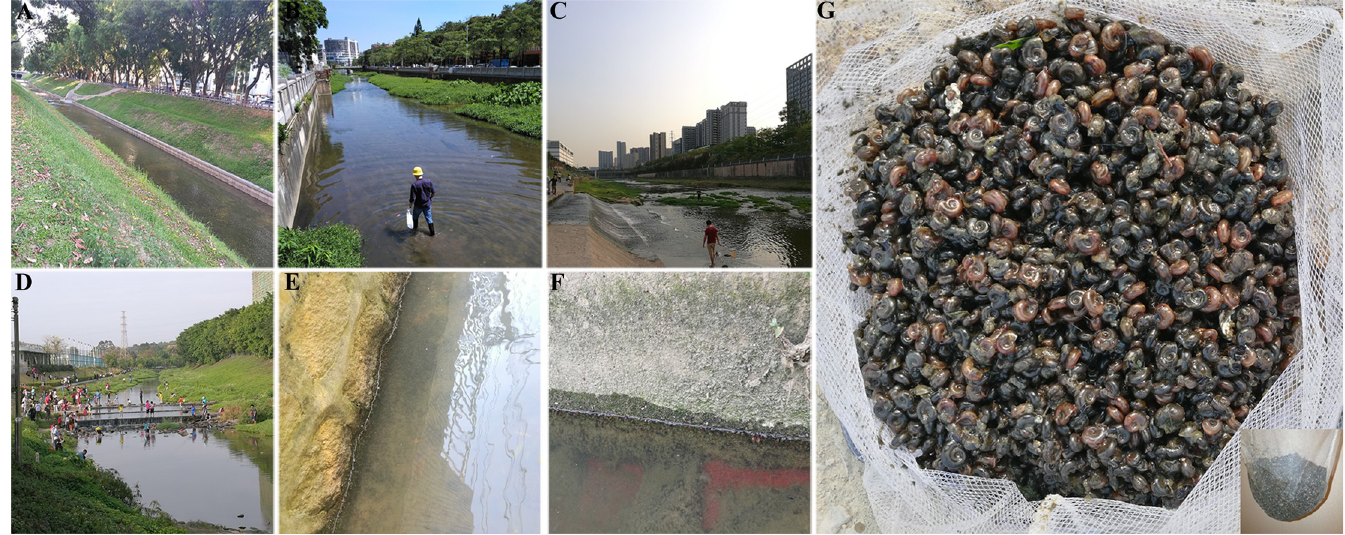
Fig 1. Pictures of typical Biomphalaria habitat in Guangdong. ( A ) River in the Xinzhou road. ( B ) Xixiang River and collecting snails. ( C ) Guanlan river and citizens playing with water. ( D ) Donghu park and citizens playing with water. ( E ) and ( F ) Biomphalaria snails in the field. ( G ) Captured Biomphalaria snails with RBS and BBS.